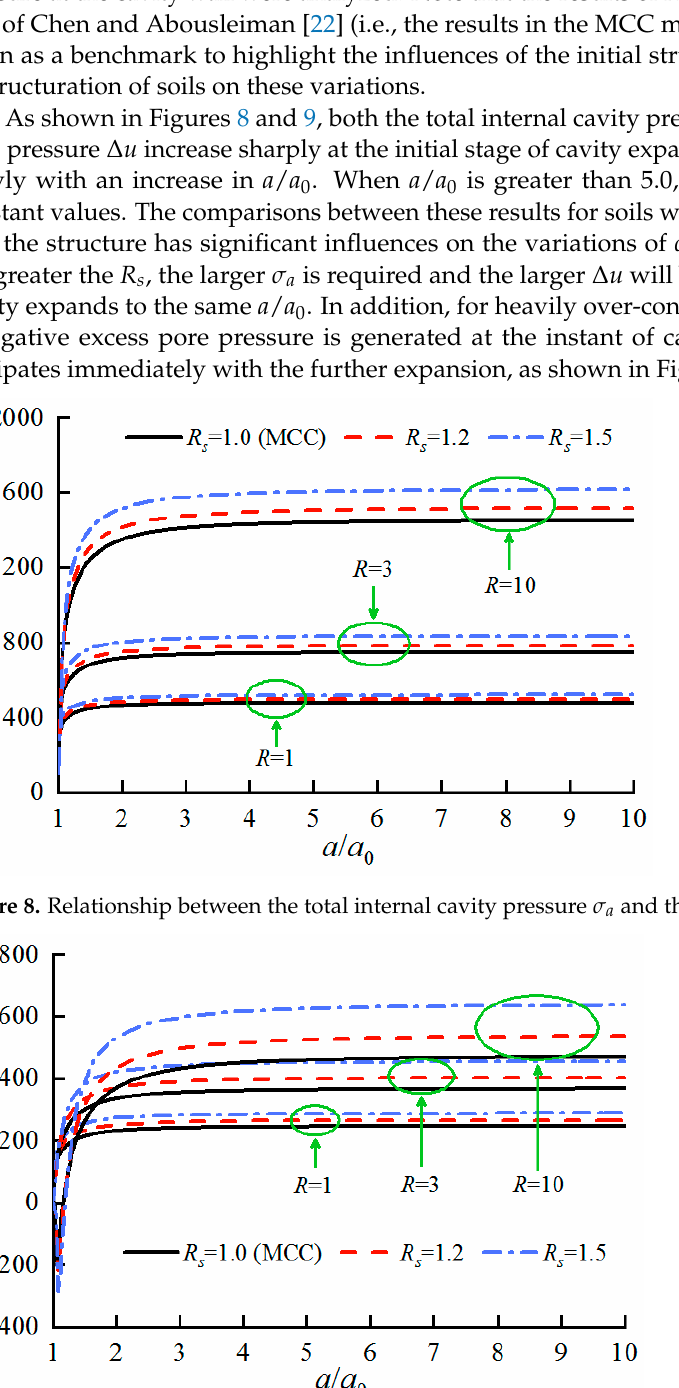
Figure 7. Comparison between the present solution and the previous solutions: distributions of p ′ , q , and Δ u along r / a .